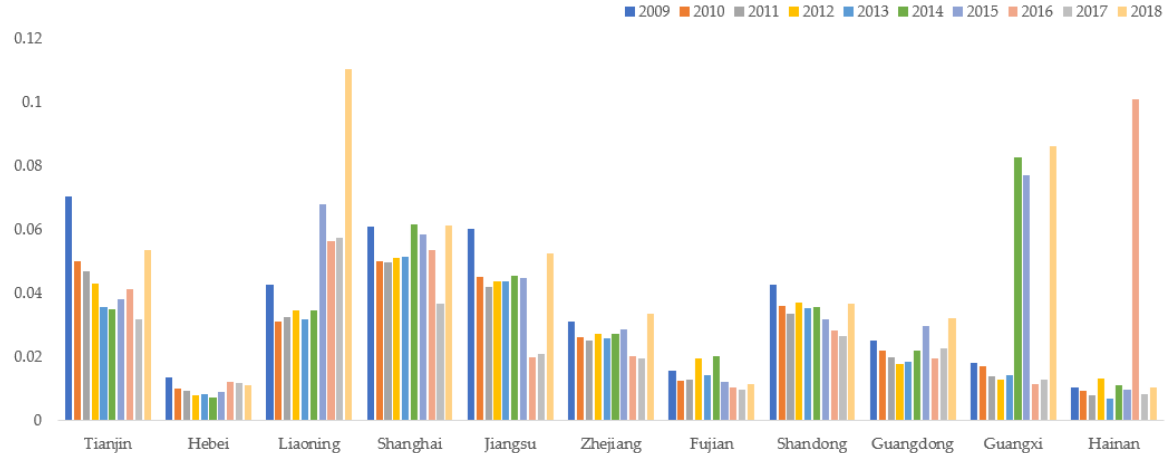
Figure 4. Chart of marine technology investment as a share of GDP.